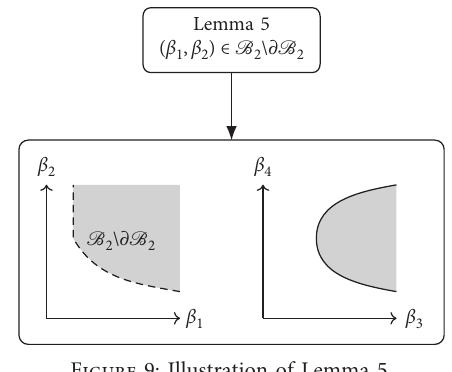
Figure 9: Illustration of Lemma